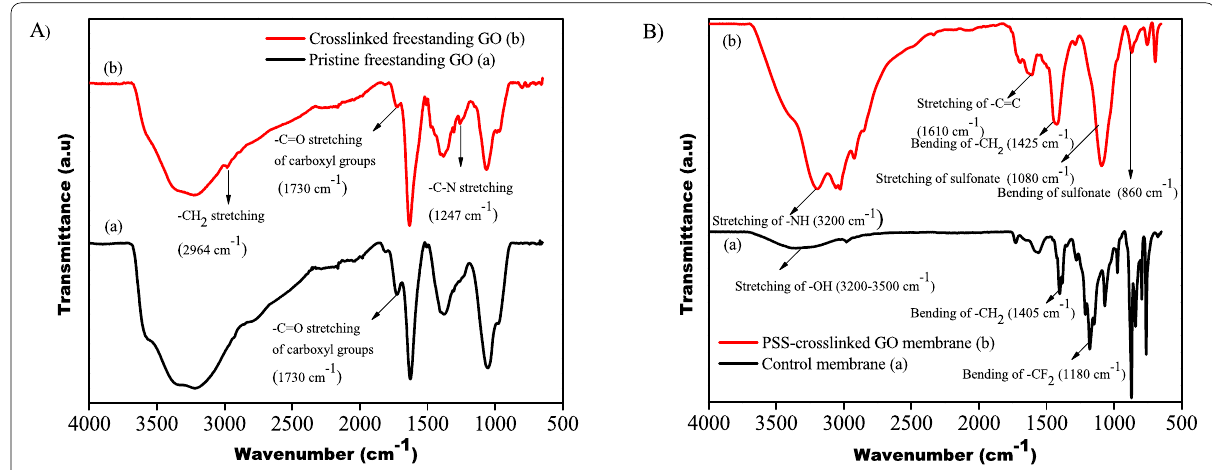
Fig. 6 IR spectra of ( A ) pristine GO and crosslinked GO ( B ) control membrane and PSS-PDA-crosslinked GO